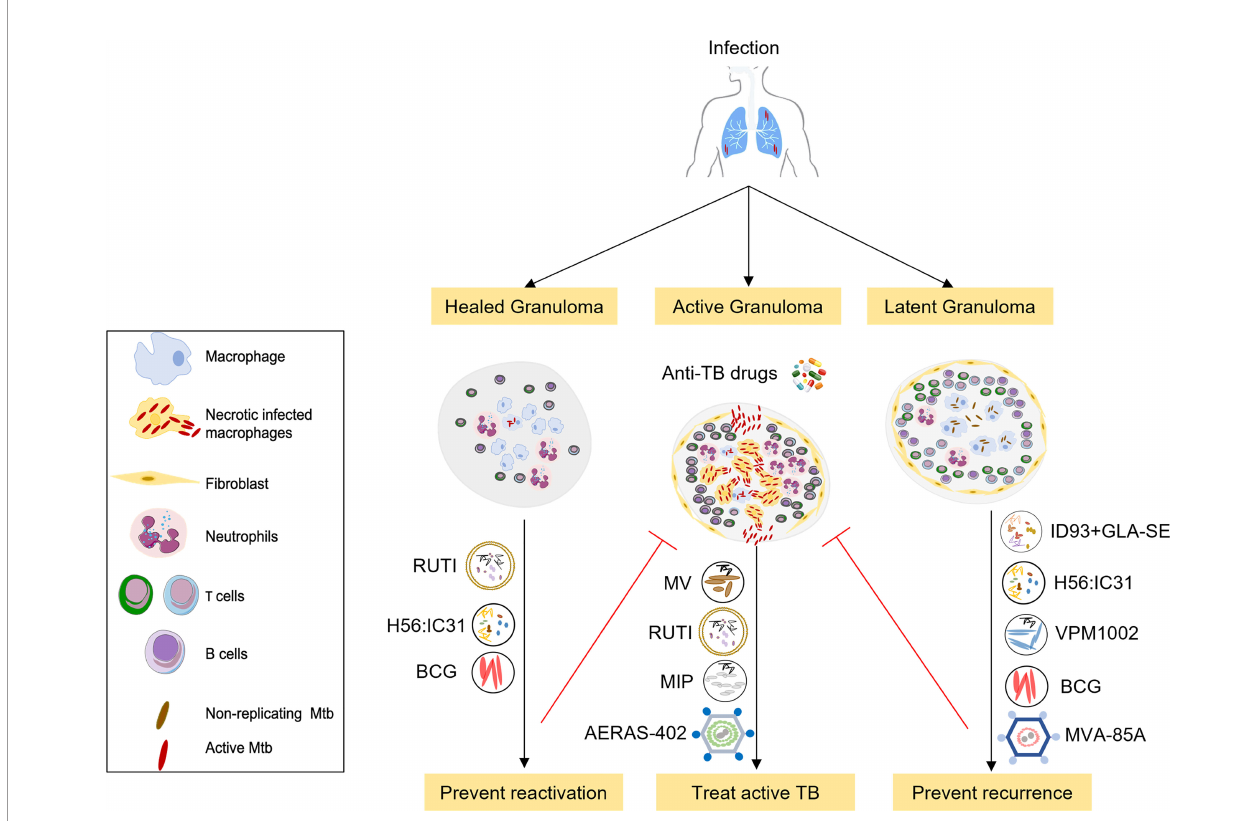
FIGURE 1 | Overview of selected therapeutic TB vaccines in the clinical pipeline. The initial stages of TB infection involve inhalation of Mtb bacilli into the lung and phagocytosis by resident alveolar macrophages. The human immune system can contain or eliminate Mtb infection in the majority of cases, only a small proportion of exposed individuals go on to develop active tuberculosis. Therapeutic TB vaccines serve as immunotherapeutic adjuncts to chemotherapy and act through modulating host anti-TB immunity. These vaccines are either administrated to potentiate treatment during treatment of active disease (middle) or to prevent recurrence or relapse after standard treatment (right), or to prevent reactivation of latent tuberculosis to active tuberculosis (left). Vaccines that are being developed to improve treatment outcomes in active TB comprise M. vaccae , RUTI, MIP and AERAS-402. Vaccines that prevent relapse and reinfection include H56:IC31 and ID: GLA-SE subunit vaccines, RUTI, BCG, the recombinant BCG vaccine VPM1002 as well as MVA-85A. These candidates are currently in phase 2 or 3 clinical trials in TB patients during or after completion of